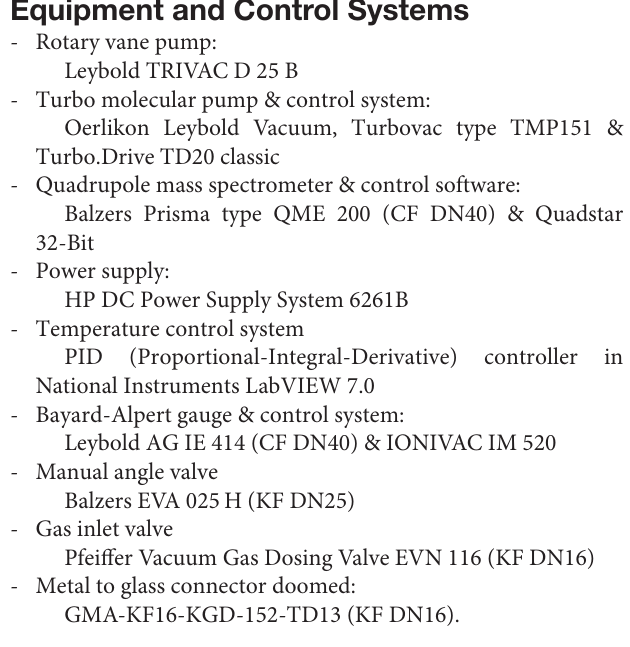
attached to the bottom side of the main chamber (see Figure 1 ), followed by a rotary vane pump not shown in Figure 1 . The mounted onto the left and onto the right side of the